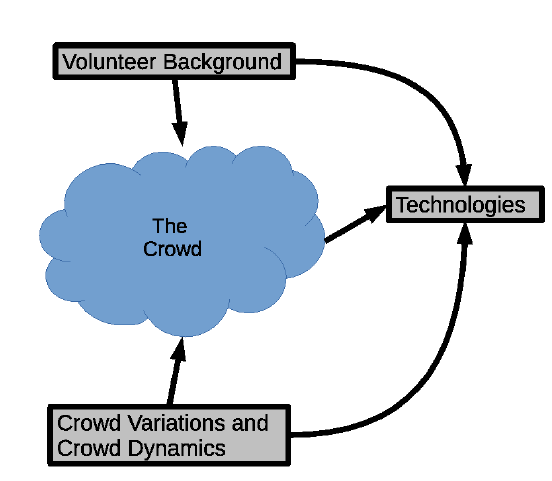
Figure 1: An overview of how the background of contributors, variations in the structure of citizen networks and the technolo- gies used in VGI and CS interact with each other. The back- ground of the contributors, the variations in how crowdsourced communities are structured and the technologies they are using for data/information collect are all interconnected and need to be considered why assessing the characteristics of a particular crowd or VGI/CS